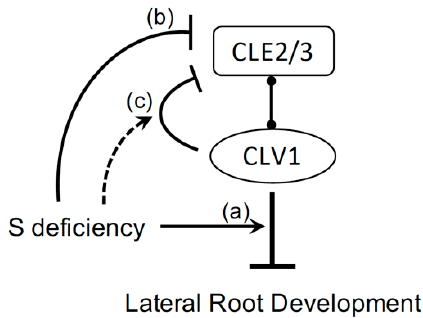
Figure 6. Schematic model of signaling pathway controlling lateral root development under S-deficient conditions. S availability a ff ects the activity of the signaling module composed of CLAVATA3 (CLV3) / EMBRYO SURROUNDING REGION (CLE) peptides and CLAVATA1 (CLV1) leucine-rich repeat receptor kinase in roots. The model proposes three potential pathways involved in regulation of LR development under S-deficient conditions. Regulatory components expressed downstream of CLV1 become active under S deficiency and inhibit LR development ( a ). CLE2 and CLE3 can be repressed under S deficiency directly or partially through the CLV1-mediated feedback mechanism (at least for CLE3) to reduce the input of CLE signals ( b , c ).